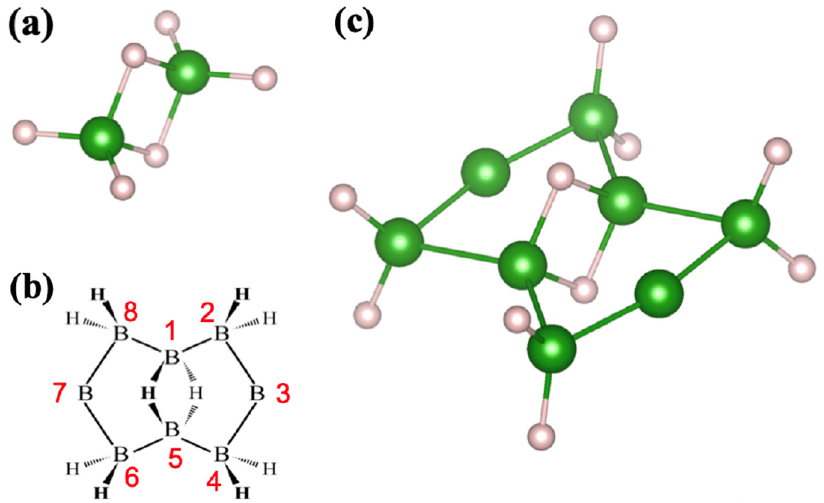
Figure 1. Molecules of hydrogenated boron compounds. ( a ) Atomic structure of diborane, B 2 H 6 . ( b ) A structural formula and ( c ) the optimized molecular structure of 2:4:6:8:-2H-1,5:1,5- µ H-B 8 H 10 . Numbers of the boron atoms for nomenclature are labeled in ( b ).